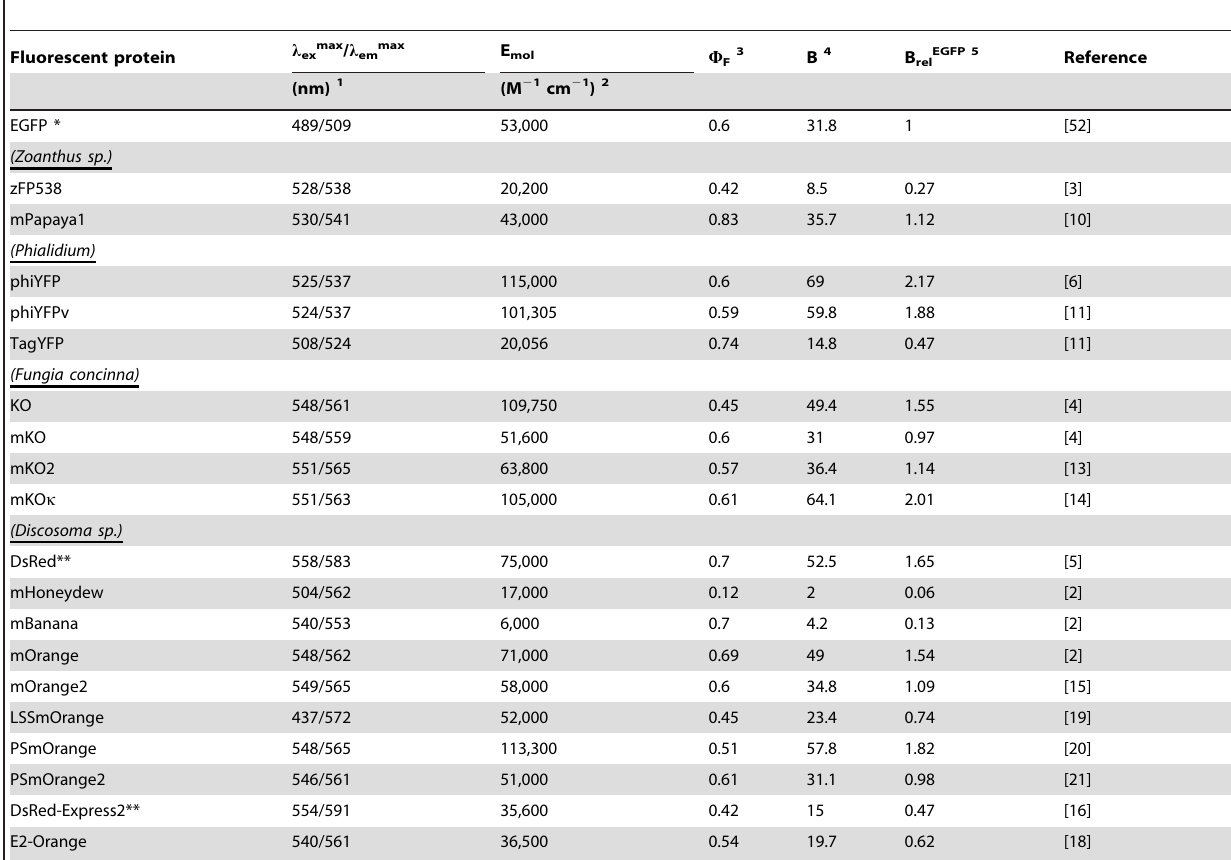
Table 1. Spectral and evolutionary features of orange fluorescent proteins.